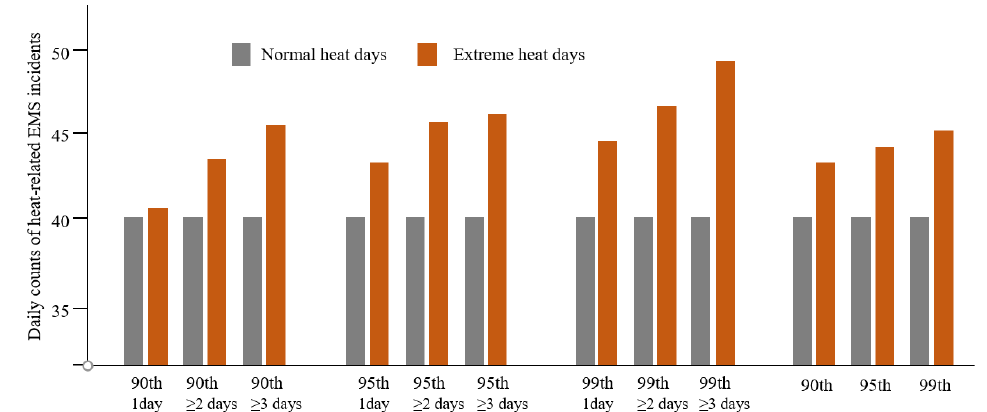
Figure 1. Comparison of daily number of heat-related EMS incidents between normal heat days and extreme heat days. An extreme heat day was defined using the intensity (90th, 95th, 99th) and duration (1 day, ≥ 2 days, ≥ 3 days). Table 2. Correlations for census block group